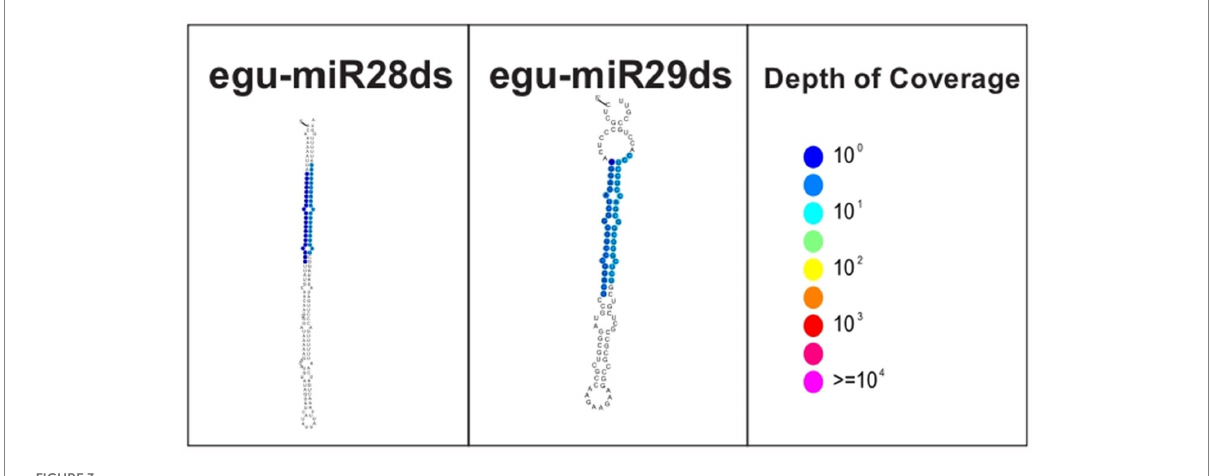
FIGURE 3 Structure of the new miRNAs identified in oil palm under water